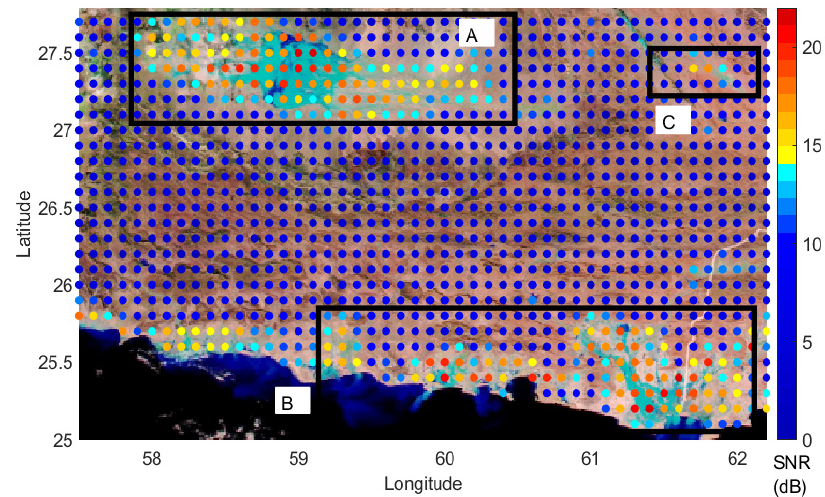
Figure 10. The georeferenced optical satellite imagery of the flood from MODIS (13 January 2020) overlaid by the corrected signal to noise ratio derived from CYGNSS observations (13 January to 15 January 2020). The regions labeled A, B, and C show significant SNR anomalies. Region A in Figure 10 belongs to the Hamun ‐ Jaz Murian depression in the southeast of Iran, placed between the Kerman province and Sistan and Baluchestan province. The shape of the depression or basin is oblong and enclosed by the mountains. There is a seasonal lake, Hamun, in the